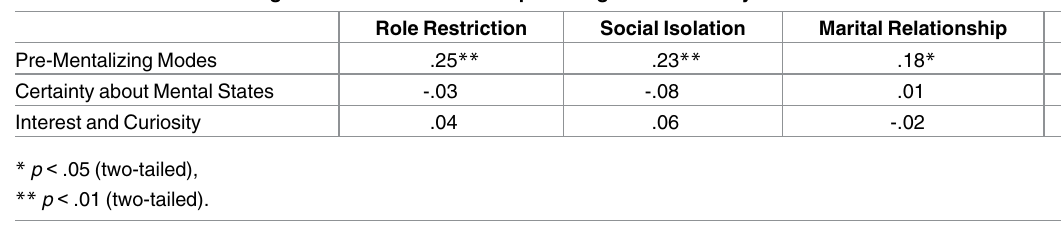
Table 8. Correlations among the PRFQ subscales and parenting stress in Study 2 for fathers and mothers